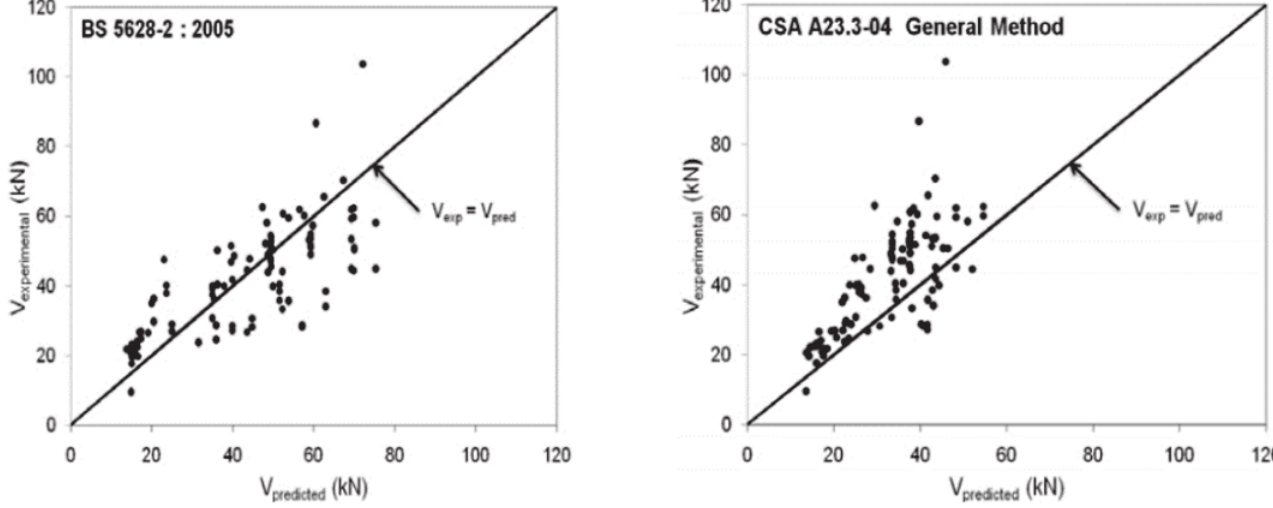
Comparison between experimental and predicted shear force values Source: Sarhat and Sherwood (2007)